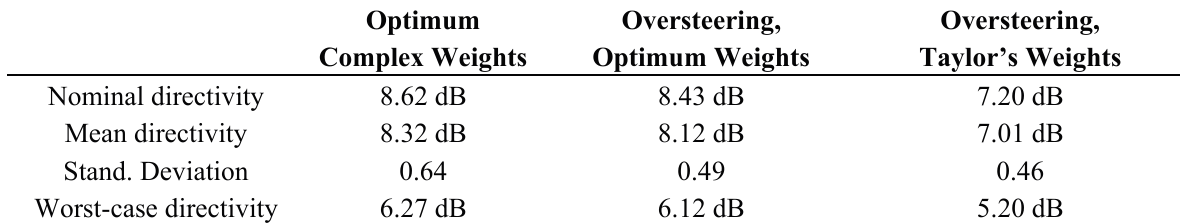
Table 1. Nominal directivity compared with the sample mean and worst-case value of the actual directivity for an end-fire array of 8 microphones and 10 4 realizations of the mismatches; Optimum complex weights, oversteering with optimum weights, and oversteering with Taylor’s weights are considered; The standard deviation (as a linear scale) of the actual directivity is included.